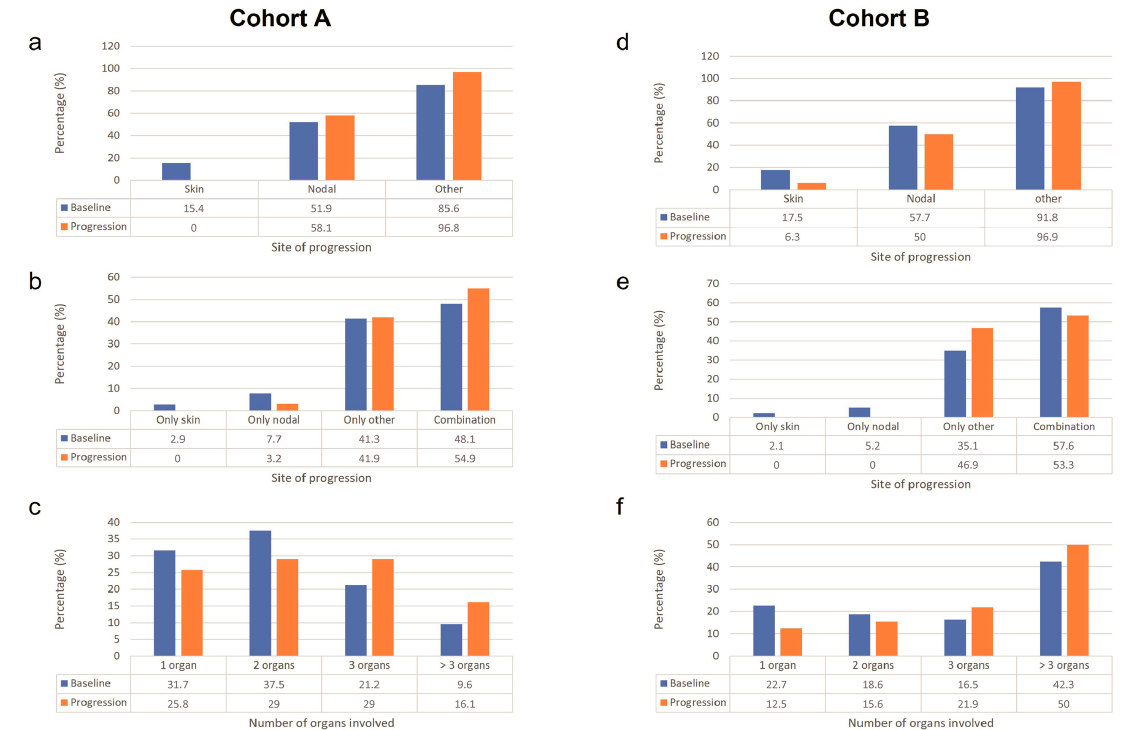
Figure 1. Disease progression. Patterns of progression in patients with limited disease (cohort A—( a – c )) or bulky disease (cohort B—( d – f )). Panels ( a ) and ( d ) describe the overall changes in the site of progression, showing an increase in the proportion of patients with lesions at lymph nodes and other sites at the time of progression. Panels ( b ) and ( e ) represent the proportion of patients who presented a lesion only in the skin, lymph nodes, other sites, or in a combination of sites; the most relevant change was observed in cohort B for the proportion of patients with lesions in other sites that increased at the time of progression. Panels ( c ) and ( f ) describe the proportion of patients according to the number of involved organs, showing an increase in the proportion of patients with at least 3 organs involved in both cohorts.